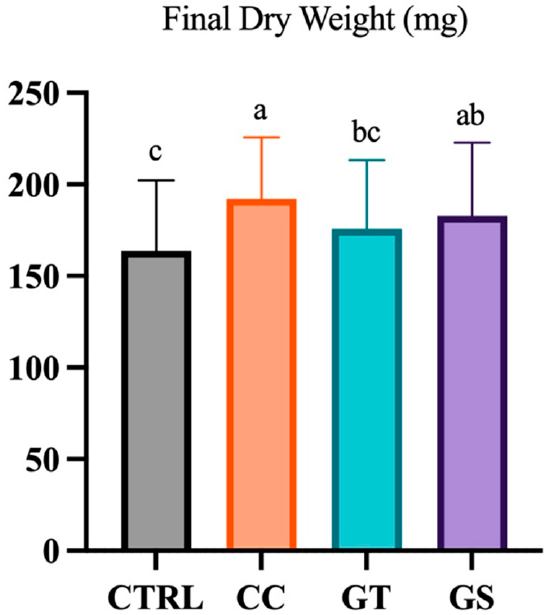
Figure 1. Dry weight (DW, mg) of Senegalese sole fed different diets (CTRL, CC, GT, and GS) at the end of the growth trial (70 DAH). Values are present as means ± SD. Different superscript letters indicate significant differences ( p < 0.05, 1-way ANOVA) between the dietary treatments.